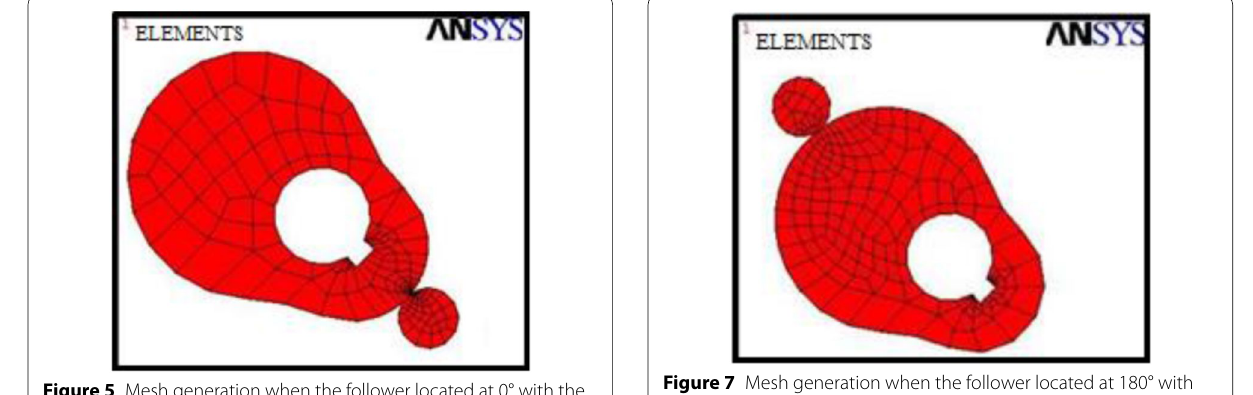
Figure 5 Mesh generation when the follower located at 0° with the cam